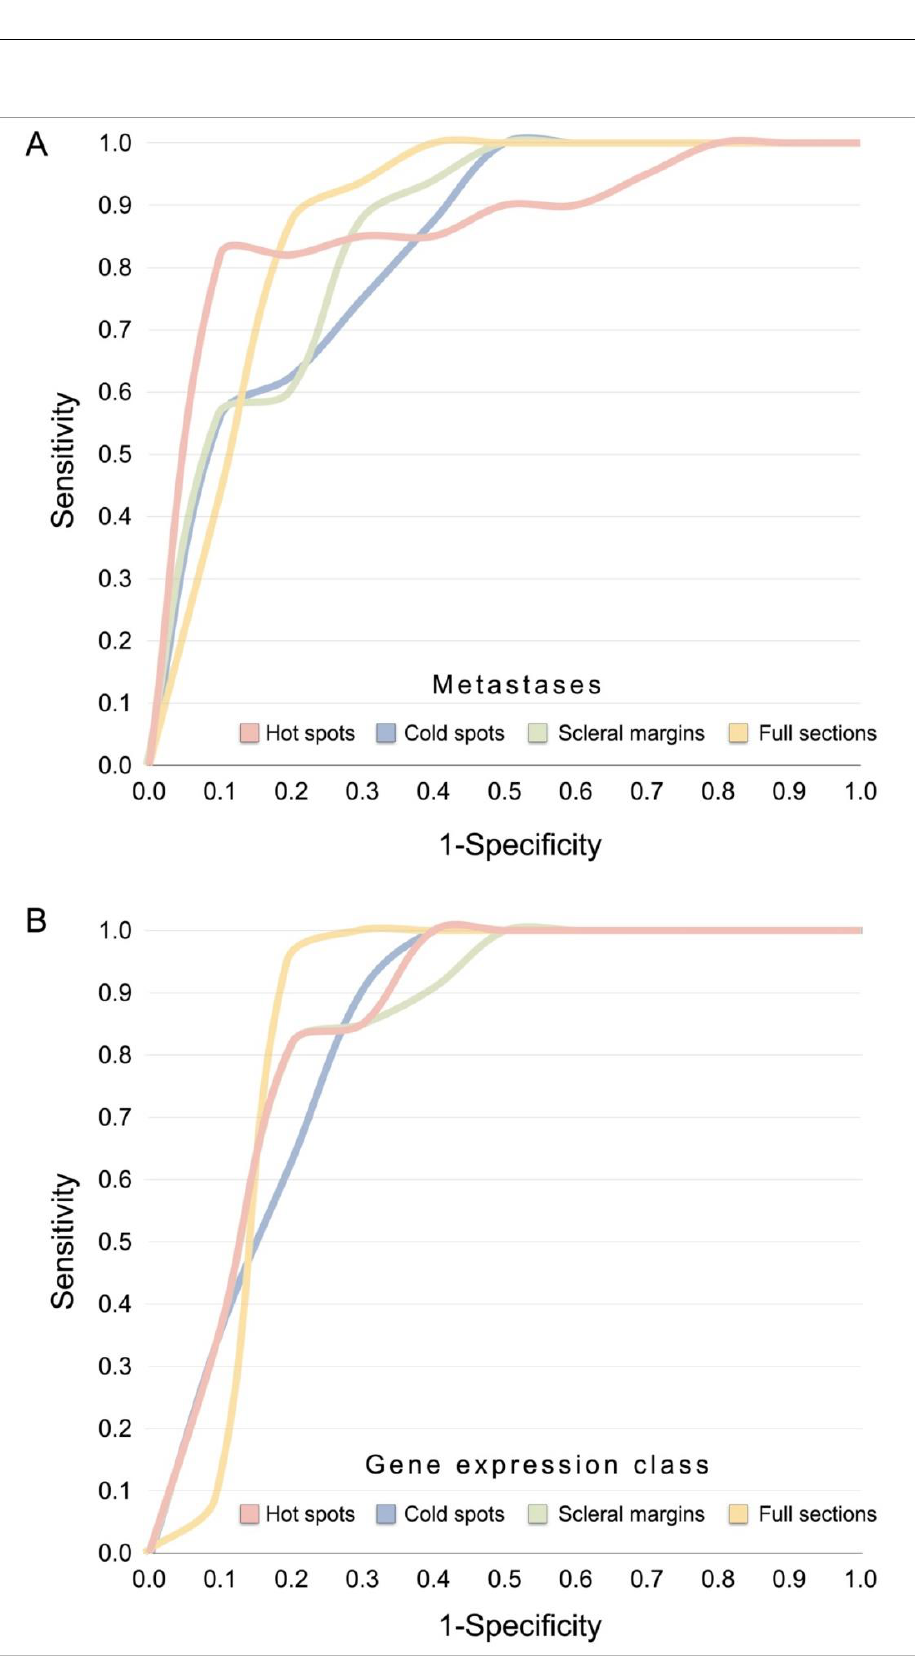
Figure 4. Receiver operating curves. ( A ) For metastases, AUCs of 0.86 to 0.89 were achieved, depending on tumor region ( p < 0.0001), with sensitivities in the range of 75 to 88% and specificities in the range of 75 to 92%. ( B ) For gene expression class 2, AUCs of 0.85 to 0.86 were achieved ( p = 0.001 to 0.002), with sensitivities in the range of 82 to 100% and specificities in the range of 73 to 83%. See also Table 2. Abbreviations: AUC, area under the curve.